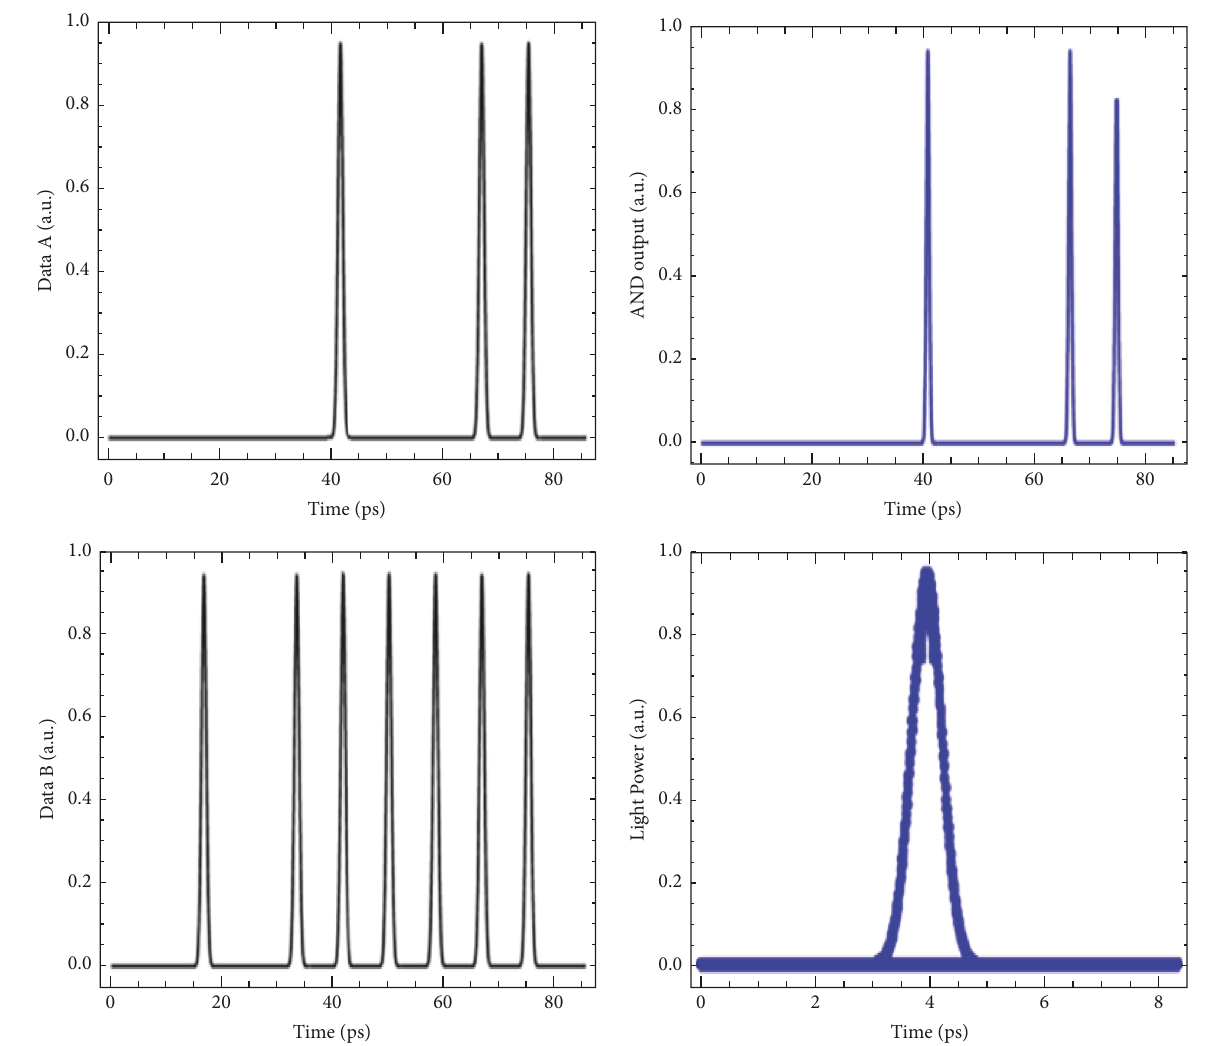
Figure 2: Simulation results and the corresponding eye diagram for AND operation. The achieved QF is 34.6 at a data rate of 80 Gb/s.